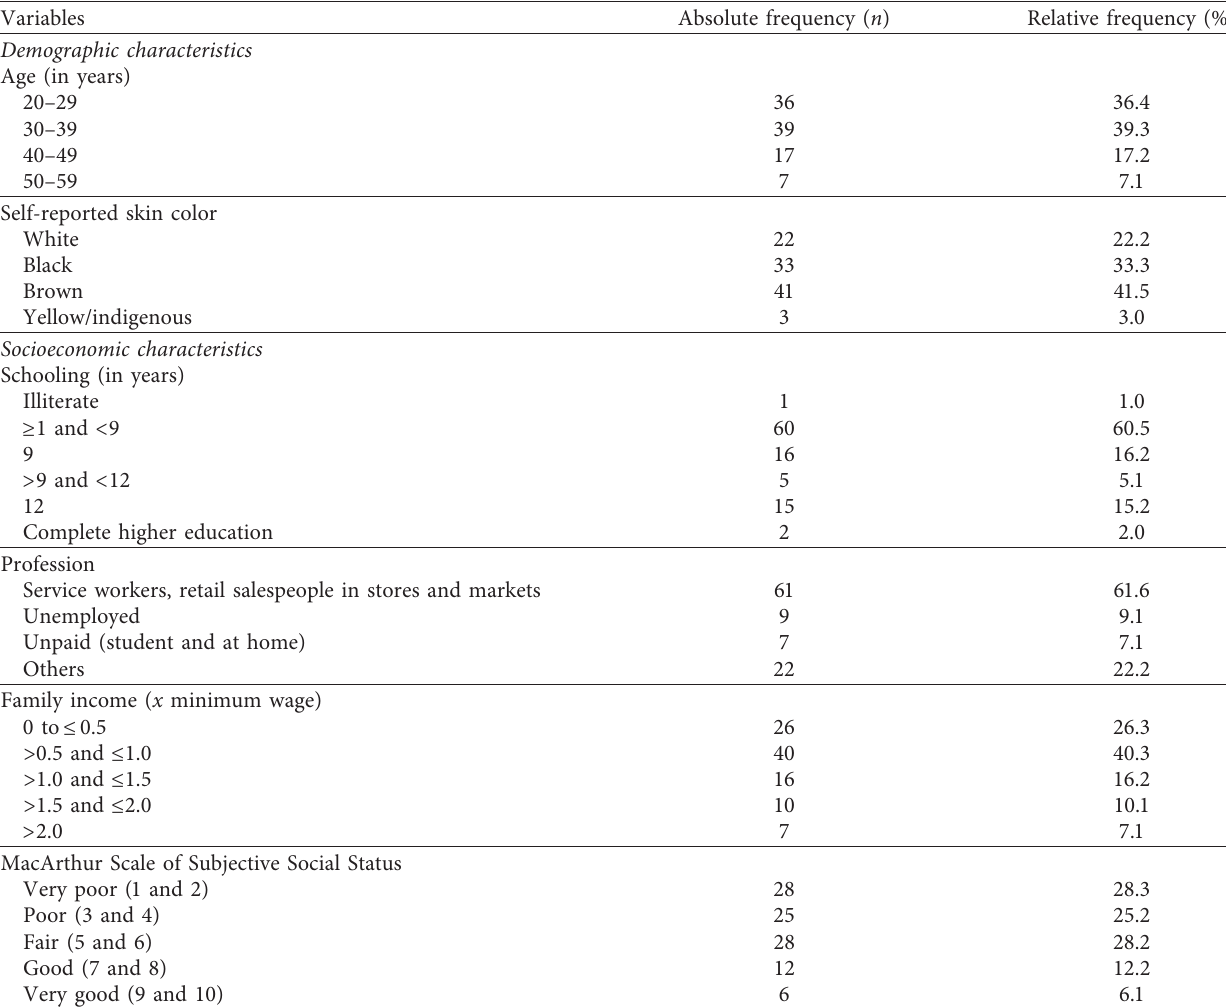
Table 1: Demographic and socioeconomic characteristics of women inmates in Juiz de Fora,